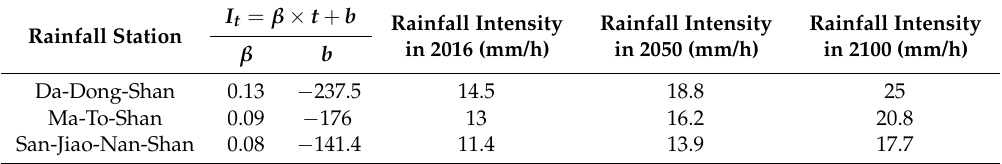
Table 4. One-day maximum rainfall intensity for the period of 2016, 2050 and